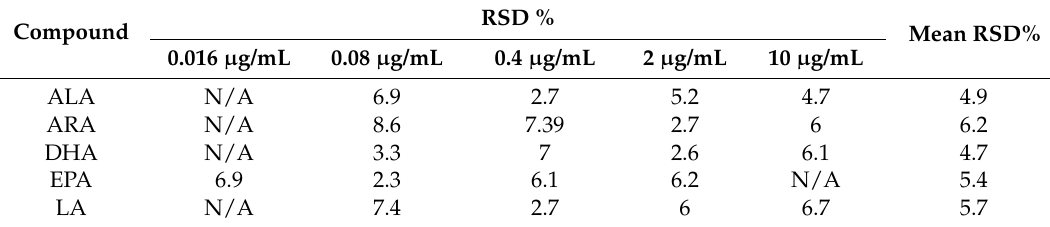
Table 3. The results for replicated analysis of standards (test accuracy). Each standard was analysed 10 times and the peak area was used to calculate the relative standard deviation (RSD). RSD % Compound